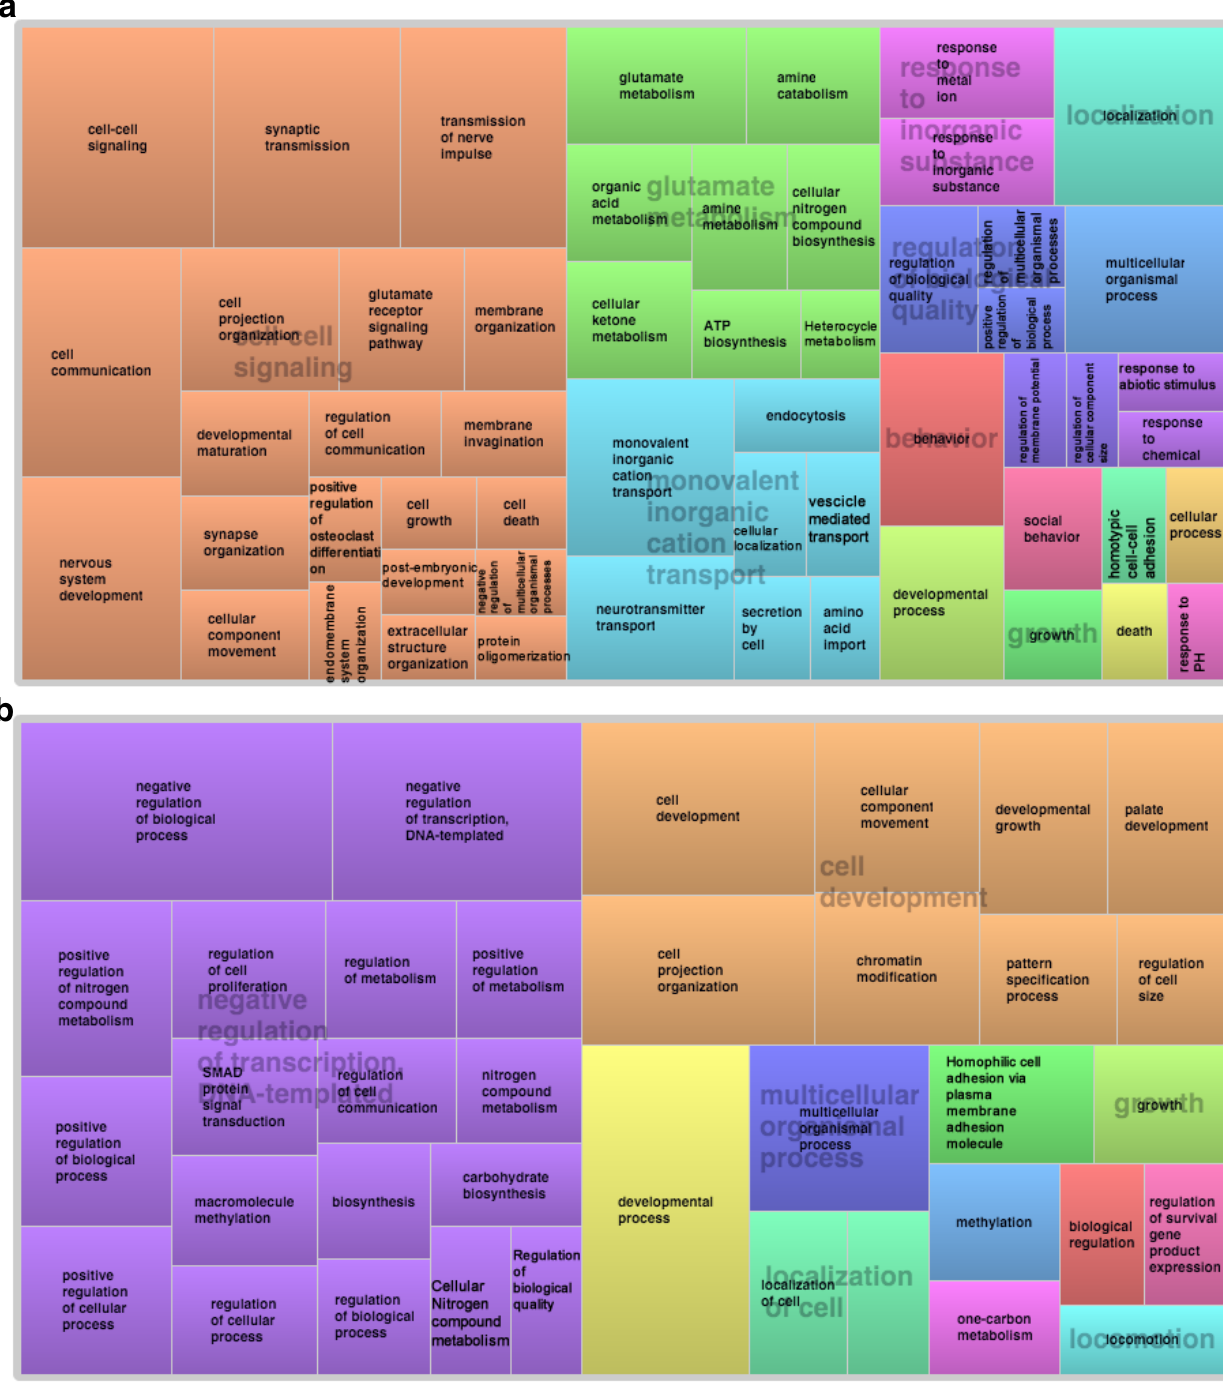
Figure 7. REViGO tree analysis of over-represented Gene Ontology (GO) terms obtained with DAVID. Panel ( a ) shows GO (Biological Process) terms associated with the 86 intellectual disability (ID) genes with a Brain ratio of 2 or more, while panel ( b ) shows GO (Biological Process) terms associated with the 64 ID genes with a Fetal Brain ratio of 2 or more. DAVID, Database for Annotation, Visualization, and Integrated Discovery; REViGO, Reduce + Visualize Gene